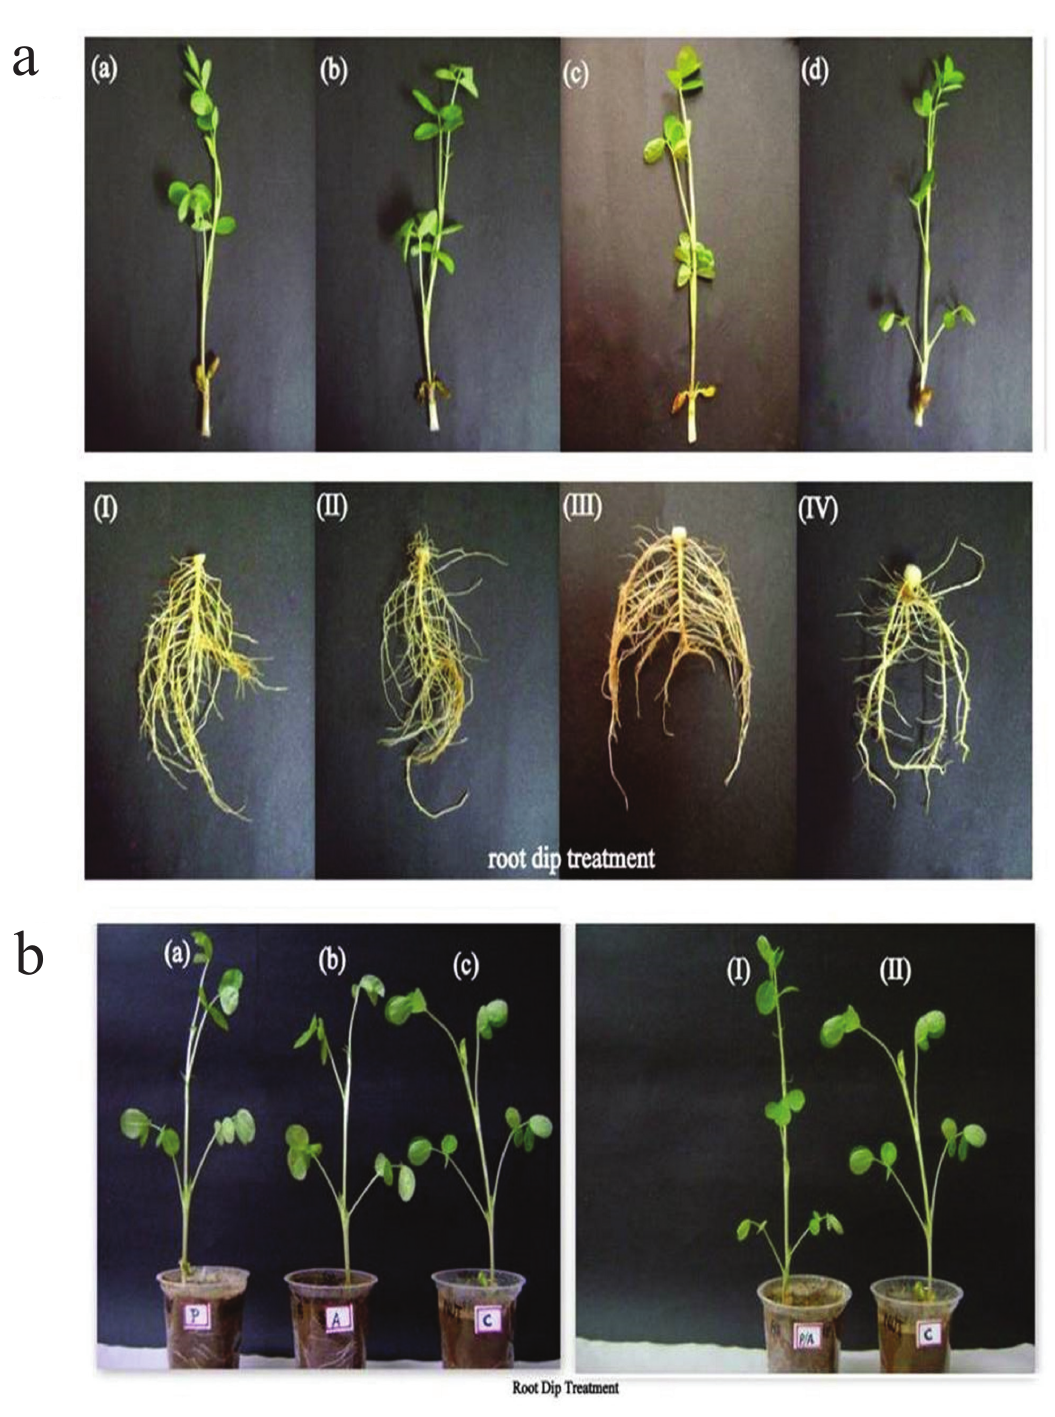
Figure 4 - Growth of groundnut plants under seedling root dip treatment with PGPR. a . Root and shoot growth of groundnut under seedling root dip treatment with PGPR. (a) and (I) – Control; (b) and (II) – A. brasilense ; (c) and (III) – P. fluorescens ; (d) and (IV) – A. brasilense and P.